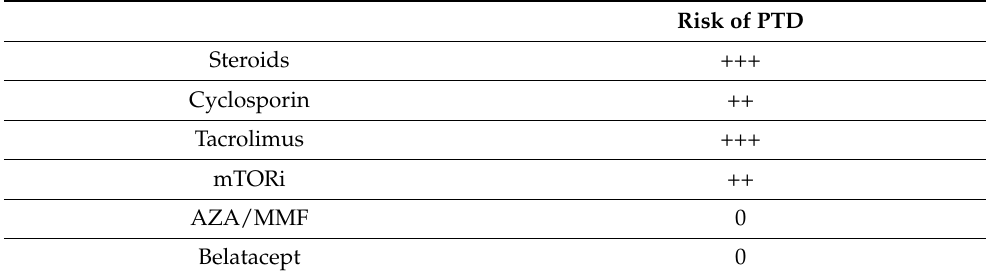
Table 1. Effects of immunosuppressive drugs on glucose